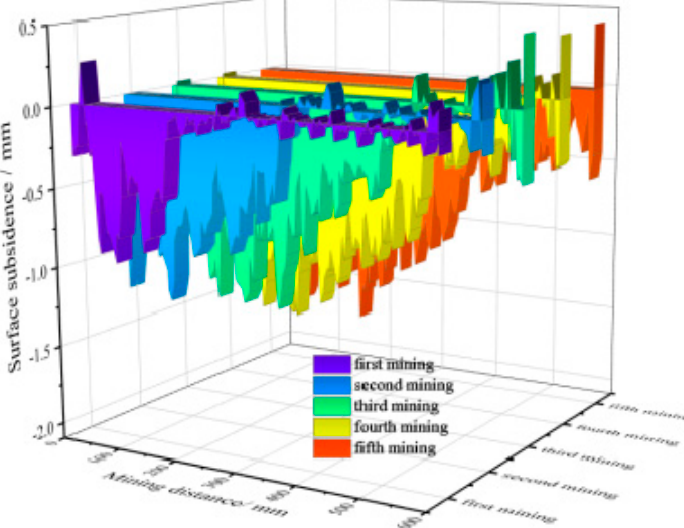
Figure 9. Three-dimensional strip diagram of surface measuring line settlement.